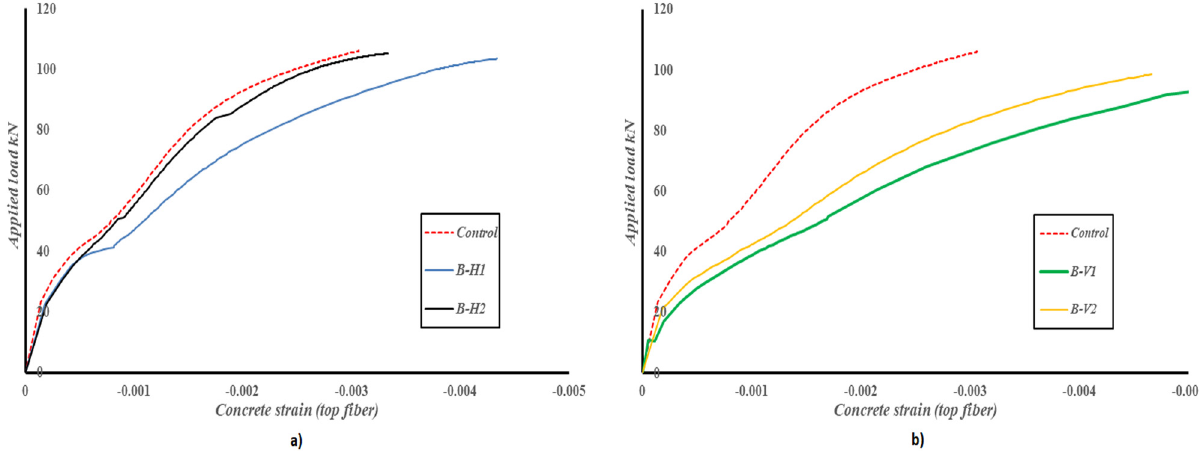
Figure 10: Load – concrete compressive strain for analyzed beams ( e ff ect of the number of openings ) . ( a ) Beams with horizontal openings and ( b ) beams with vertical